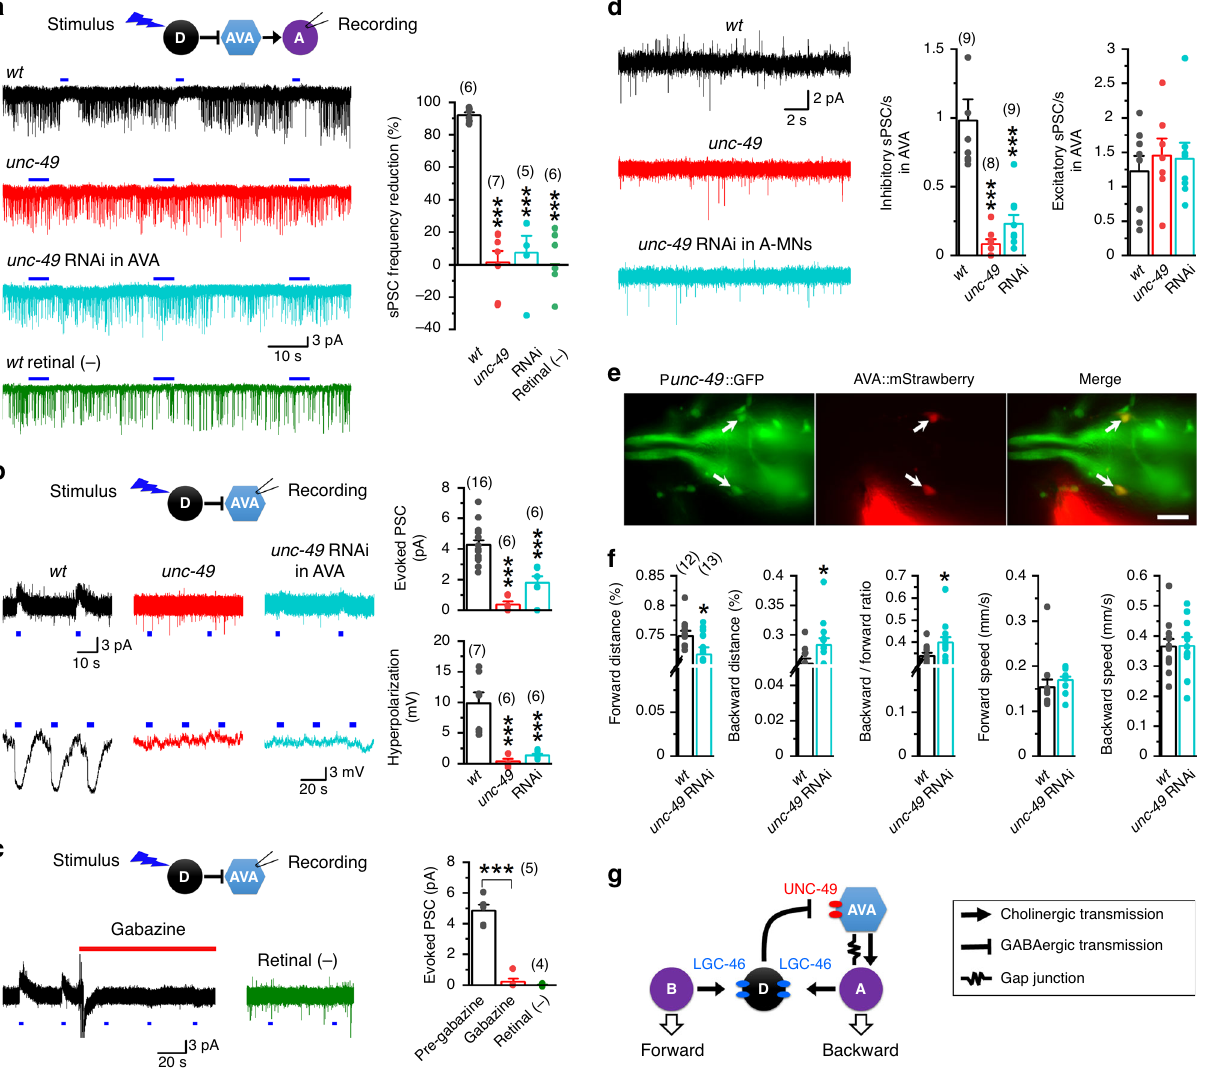
Fig. 2 D-MNs favor forward locomotion through activating UNC-49 GABA A receptor in AVA interneurons. a Optogenetic activation of D-MNs suppressed spontaneous postsynaptic currents (sPSCs) in VA5 (held at − 60 mV) without causing an evoked inward current. All worms were treated with all-trans retinal except for those of the wild-type ( wt ) control group (indicated). The bar graph shows the percentage of sPSC reduction compared with the pre-stimulation period. Only slow and large sPSCs, which result from synaptic transmission from AVA 34 , were quanti fi ed. In quantifying the effect of blue light stimulation on sPSCs, the entire interval showing an apparent lack of events was used for wt (with retinal) but only the interval matching the blue light pulse was used for the remaining groups. Compared with wt, p = 0.000 for all groups. b Optogenetic activation of D-MNs evoked outward current in AVA (held at − 10 mV) and caused AVA hyperpolarization in wt but not in either unc-49(e407) or the AVA-targeted unc-49 RNAi strain. Compared with wt , p = 0.000 for both groups. c Gabazine (500 µ M) abolished AVA outward current evoked by optogenetic activation of D-MNs. Compared with Pre-gabazine, p = 0.000 for both groups. d Inhibitory sPSCs were greatly reduced in the unc-49 mutant and RNAi strains. Compared with wt , p = 0.000 for Inhibitory sPSCs of both groups, but 0.777 and 0.844 for excitatory sPSCs of unc- 49 and RNAi, respectively. e Expression of GFP under the control of unc-49 promoter in a strain with AVA neurons labeled by mStrawberry resulted in AVA colabeling by both fl uorescent proteins. The displayed images represent >20 transgenic worms. Scale bar = 10 µ m. f Comparison of locomotor kinematics between wt and the unc-49 RNAi strain. p = 0.044 Forward distance, 0.044 backward distance, 0.049 backward/forward ratio, 0.424 forward speed, and 0.960 backward speed. g Diagram showing a closed-loop circuit that includes AVA, A-type cholinergic motor neurons, and D-MNs. The horizontal blue lines in a – c indicate the times (2 or 5 s) of blue light stimulation. The asterisks indicate signi fi cant differences (* p < 0.05, *** p < 0.001) based on either one-way ANOVA with Tukey ’ s post hoc test ( a , b, d ), paired two-sided t - test ( c ), or unpaired t -test ( f ). The numbers inside brackets indicate sample size ( n ). n = numbers of independently recorded cells in a – d , but numbers of individual worms in f . Data are presented as mean values ± SEM. Source data are provided as a Source data fi